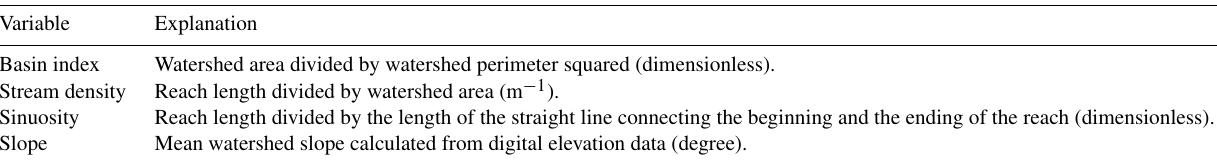
Table 1. Watershed topography predictors. Variable Explanation Basin index Watershed area divided by watershed perimeter squared (dimensionless). Stream density